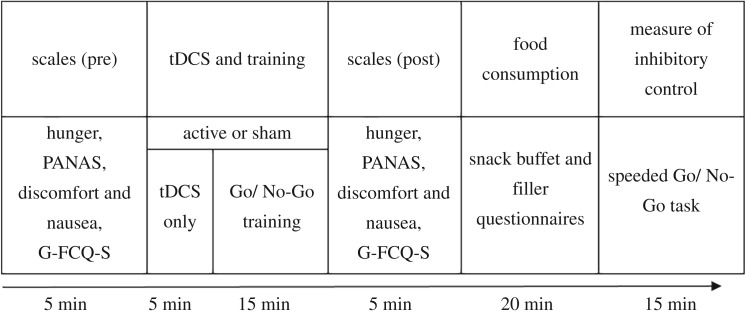
Schematic diagram of the procedure. Participants initially completed measures of hunger, mood and craving before being randomly allocated to receive either active or sham stimulation. After 5 min of stimulation a food-related Go/No-Go training task was introduced. Following this task, participants were presented with the hunger, mood and craving scales and then a snack buffet with various unhealthy and healthy foods for consumption. Filler questionnaires were provided during the buffet to keep participants occupied for 20 min. Participants then completed a speeded version of the Go/No-Go task to measure inhibitory control (full details can be found in the Method section). Note. PANAS = Positive and Negative Affect Schedule [49]; G-FCQ-S = General Food Craving Questionnaire – State Version [50]; tDCS = transcranial direct current stimulation.